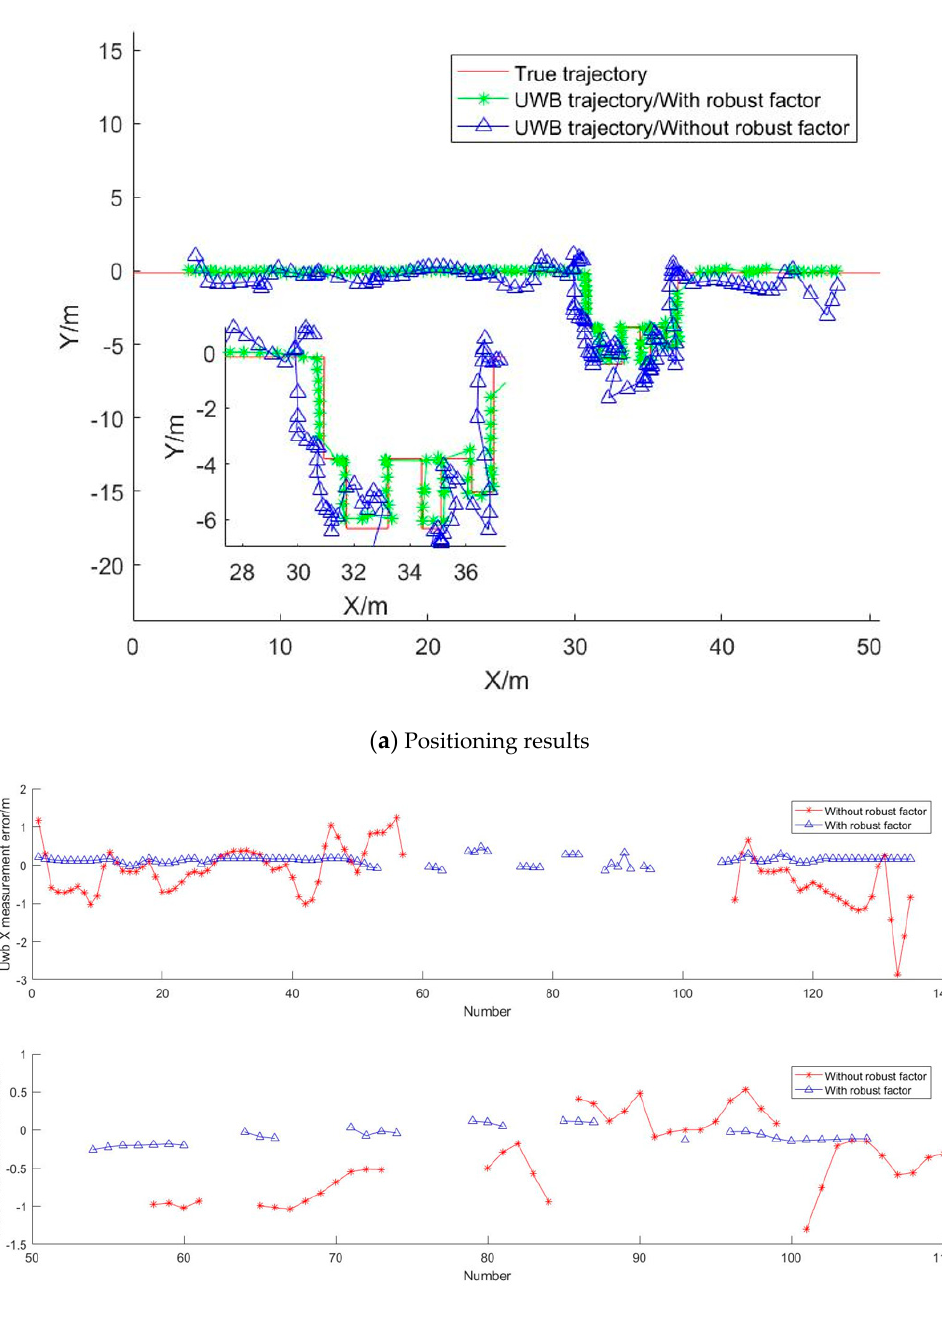
Figure 8. UWB positioning results and errors.